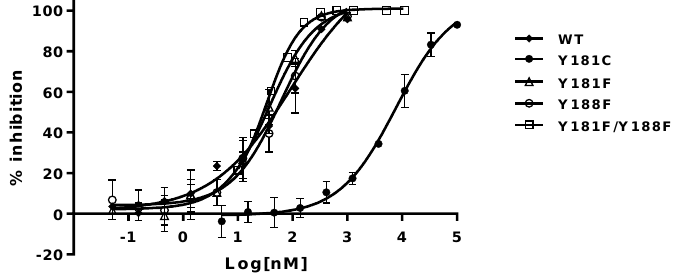
Figure 5. Inhibition curves of NVP against Y181 and Y188 mutants. The error bars are in means ± standard deviation with more than three replicates.